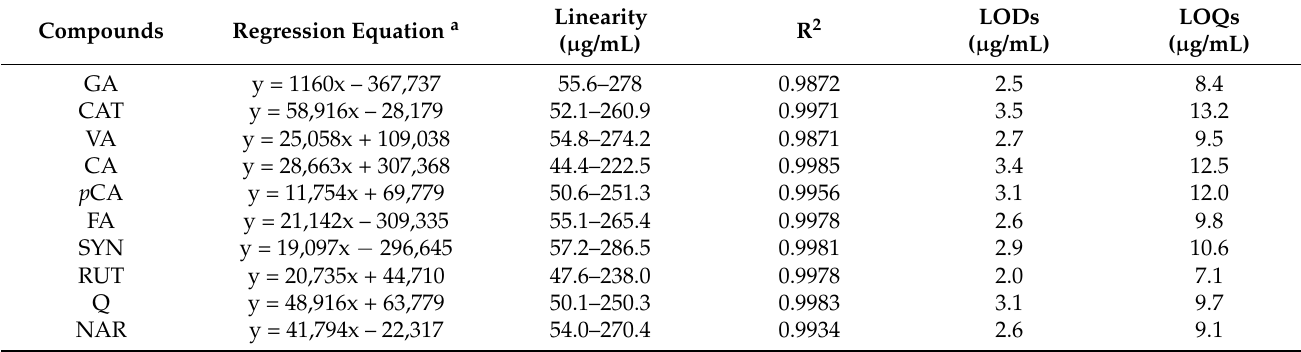
Table 2. Validation parameters of the calibration curves for the compounds quantified